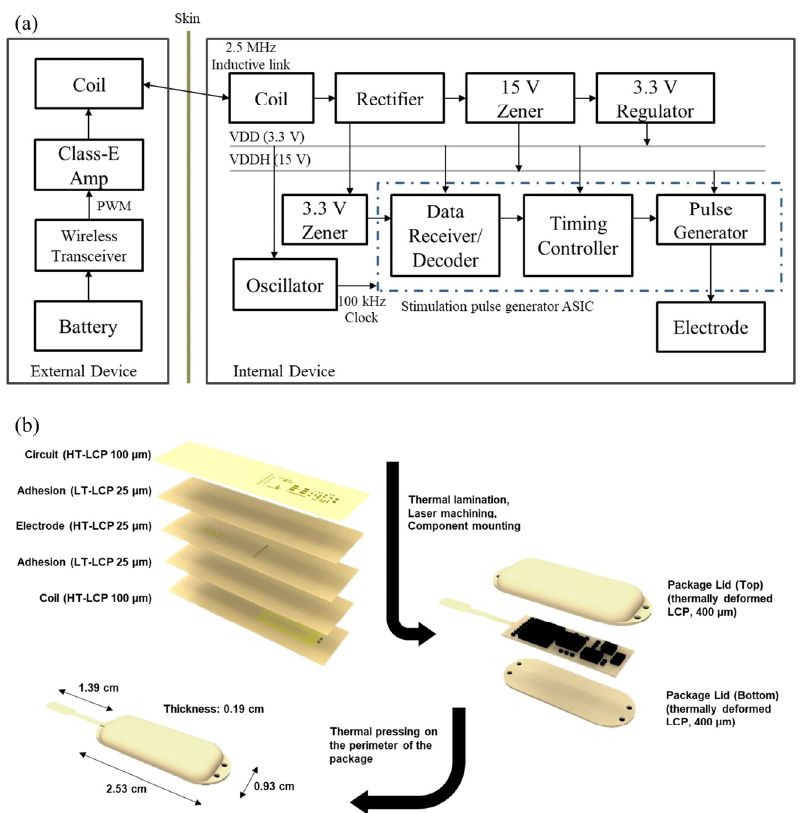
Figure 2. ( a ) A block diagram of the neural stimulator and the external relay. The internal device receives power and data from the external relay through 2.5 MHz inductive link to generate a biphasic pulse. ( b ) Fabrication process of the designed neural stimulator. Microfabricated electrode/circuit layers are thermally laminated, laser machined, and electrical components are mounted before being packaged with customized LCP (liquid crystal polymer) lids. HT-LCP: high melting temperature LCP, LT-LCP: low melting temperature LCP.